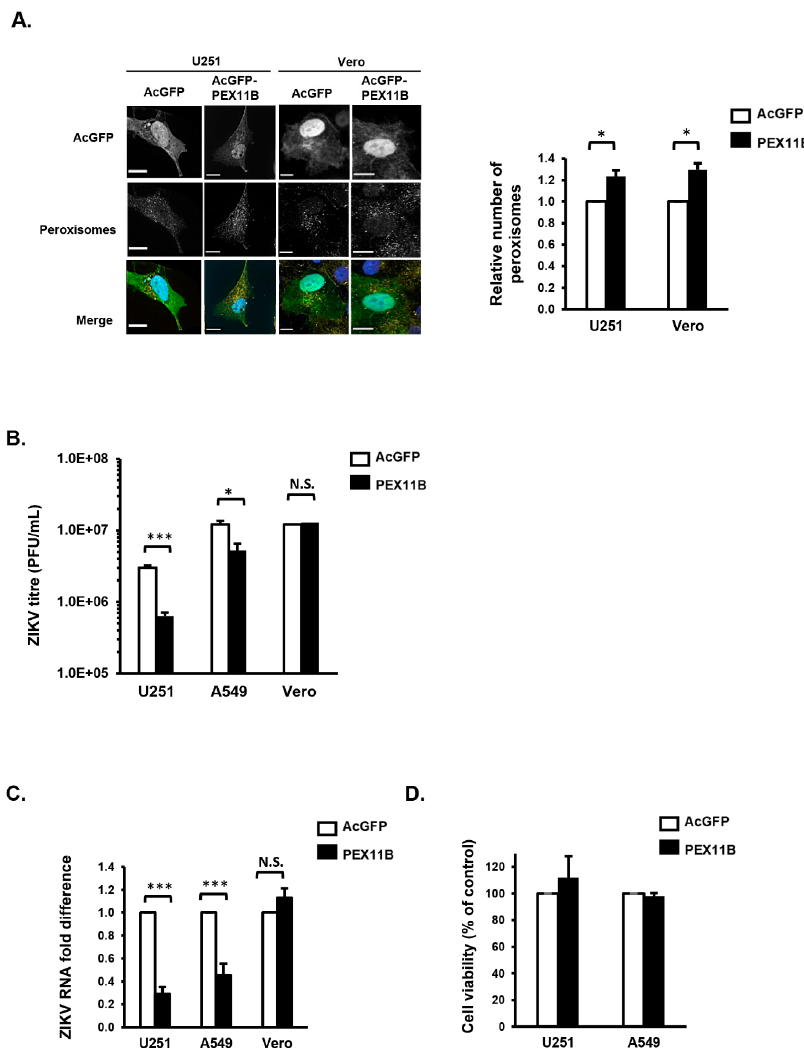
Figure 4. Over-expression of PEX11B inhibits ZIKV replication. ( A ) U251 or Vero cells were transduced with lentiviruses encoding AcGFP alone or AcGFP plus myc-tagged PEX11B for 48 h and then processed for confocal microscopy. Peroxisomes were detected with a rabbit polyclonal antibody to the tri-peptide SKL and donkey anti-rabbit IgG conjugated to Alexa Fluor 546. Nuclei were stained using DAPI. Images were obtained using spinning disc confocal microscopy. The relative numbers of peroxisomes (SKL-positive structures) in cells were determined using Volocity image analysis software. Averages were calculated from three independent experiments, in which a minimum of 20 cells for each sample were analyzed. The average number of peroxisomes in control cells was normalized to 1.0. Bars represent standard error of the mean. * p < 0.05. ( B ) U251, A549 or Vero cells were transduced with lentiviruses encoding the reporter protein AcGFP alone as a control or AcGFP plus myc-tagged PEX11B proteins for 48 h, after which the cells were infected with ZIKV PRVABC59 (MOI = 1) for another 48 h. Cell media were processed by plaque assay to determine viral titers. In parallel, cell lysates were also processed for RNA extraction and subsequent qRT-PCR to determine viral RNA level ( C ). U251 and Vero cell lysates were processed to determine cell viability ( D ). The data are averaged from the results of three independent experiments. Bars represent standard error of the mean. *** p < 0.001, * p < 0.05. N.S. = not